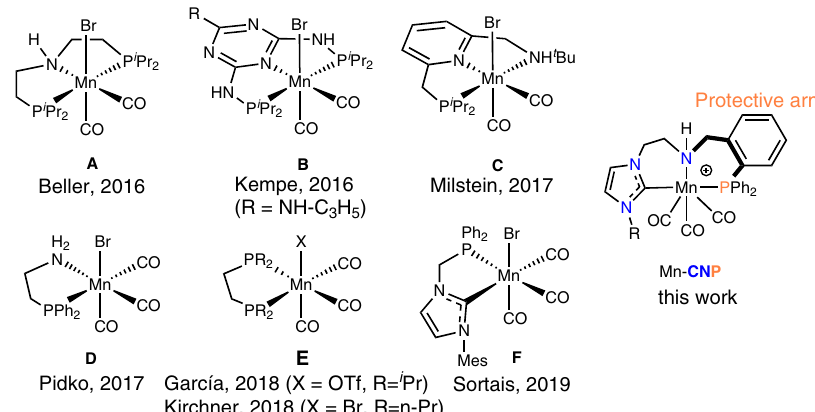
Fig. 1 Mn complexes. Selected examples of Mn hydrogenation catalysts and the complex used in this